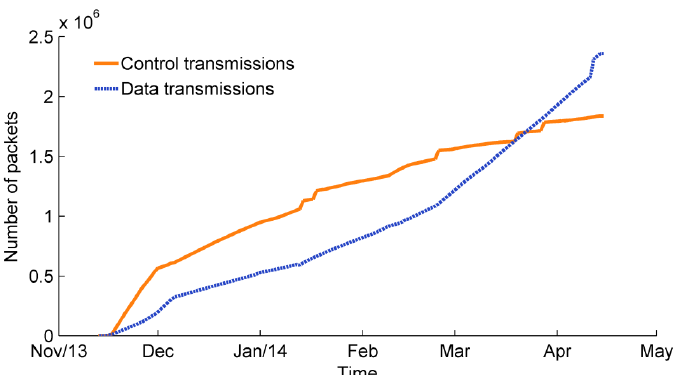
Figure 12. The cumulative number of control packet transmissions and data packet transmissions during the CTP evaluation period in the